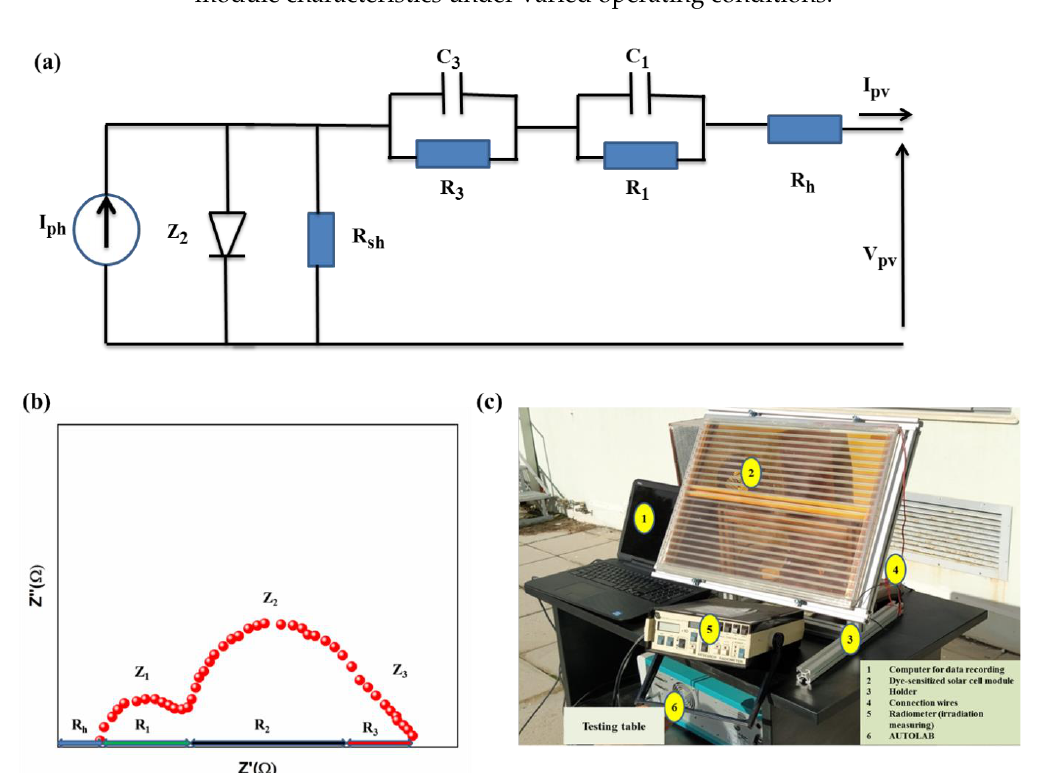
Figure 2. Single-diode model simulating the DSSC operation ( a ); DSSC electrochemical impedance spectrum ( b ); experimental setup ( c ).